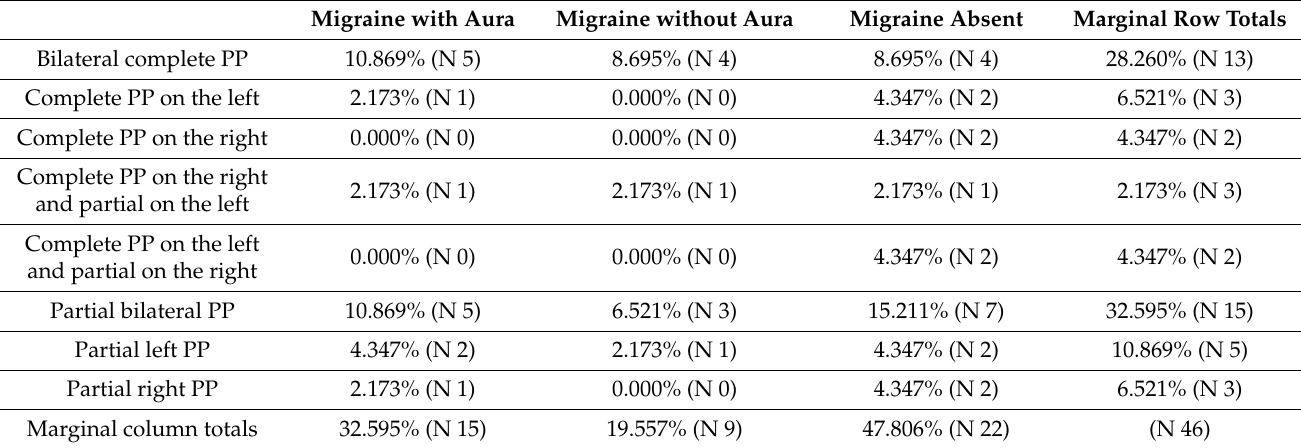
Table 2. Evaluation of PP and migraine in